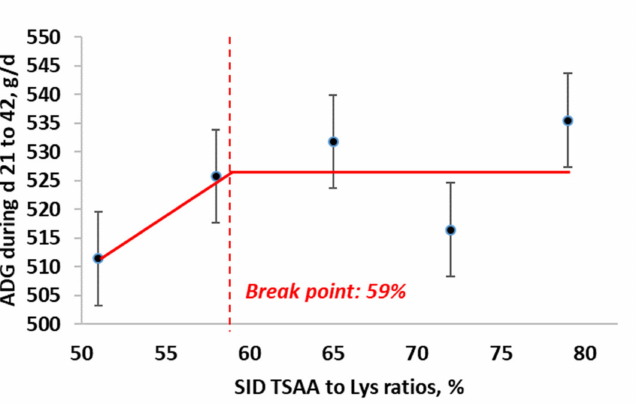
Figure 5. Broken-line linear ascending model for estimation of optimal SID TSAA to Lys ratio in nursery pigs under ABF for average daily gain from d 21 to 42.